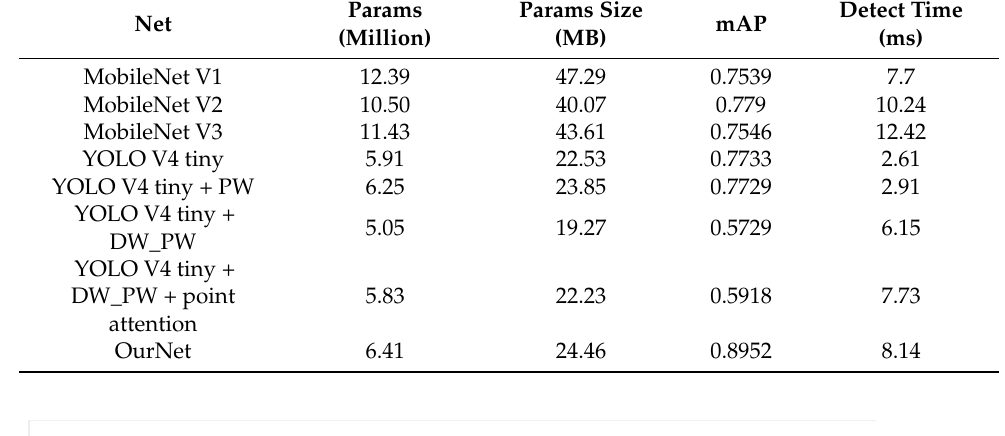
Table 2. Parameters, performance indicators, and response time of different models.